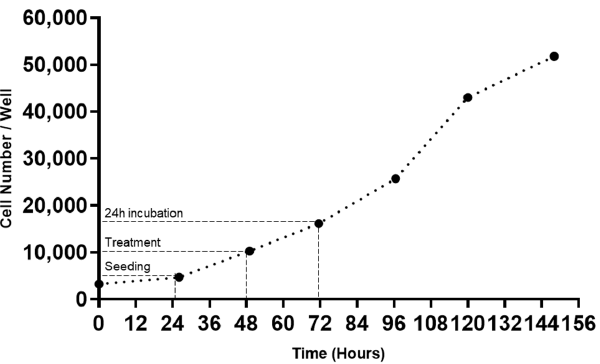
Figure 3. Growth curve of MCF-7 cells, obtained by staining these cells with the Hoechst 33342 dye and counting the total cell number, per well, for 148 h. Results from three independent experiments.